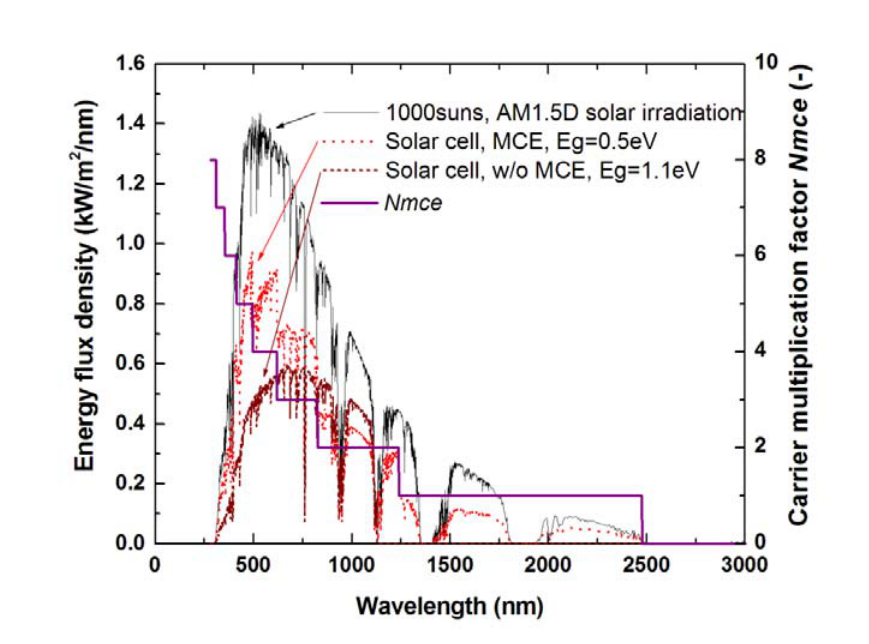
Figure 13. (Left vertical axis) Solar irradiation spectrum of AM1.5D, 1,000 suns and energy utilization spectrum by a single-junction solar cell with the optimized energy bandgap to obtain the maximum efficiency for each case with and without multiple carrier excitation (MCE). Eg = 0.5 eV, energy conversion efficiency η = 57.6% for the cell with MCE and Eg = 1.1 eV, η = 37.6% for the cell without MCE. (Right vertical axis) The carrier multiplication factor at each wavelength for the cell with MCE was also